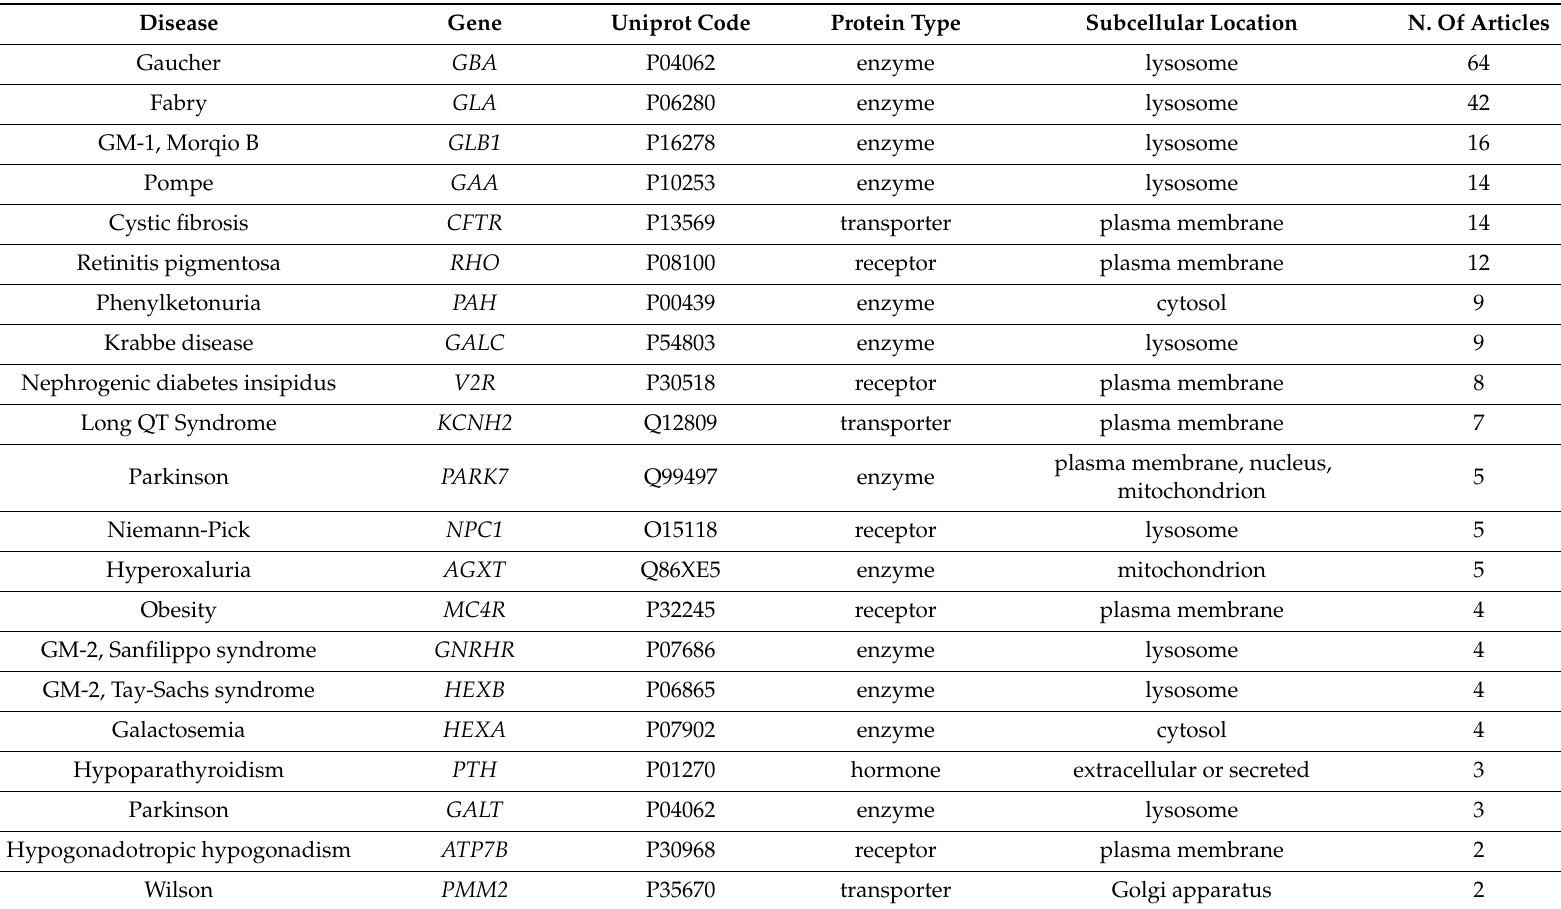
Table 1. Distribution of research papers per disease and per protein target. The table summarizes how many articles use the term “pharmacological chaperone” and the corresponding disease context (we chose arbitrarily what we considered the most representative name of the disease). The UniProt entry of the a ff ected protein, the name of the gene, the protein type, and the protein localization are also